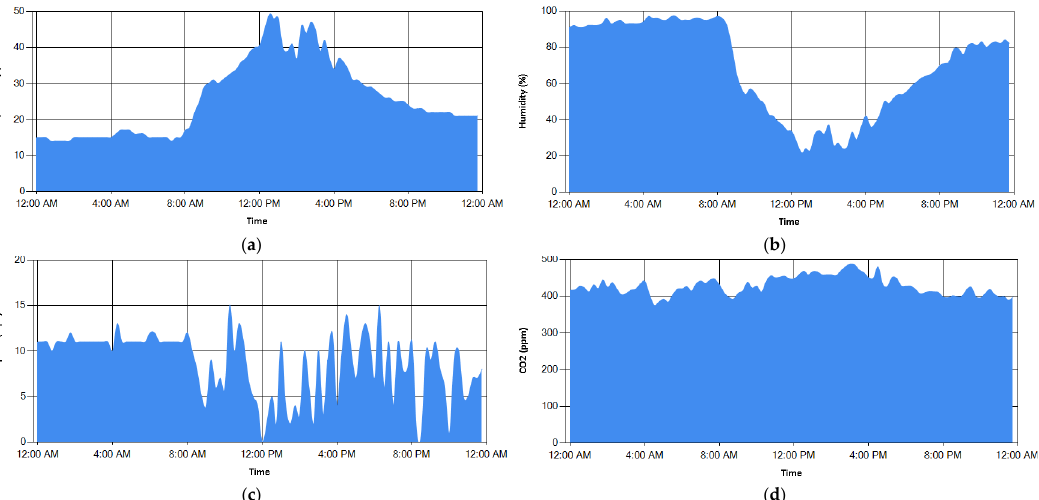
Figure 13. Screenshots of central server software and smartphone apps: ( a ) central server-marked fire event on map; ( b ) smartphone notification when smoke detected in sensor node 0; ( c ) smartphone app’s list view showing a list of fire events with location, date, and time; ( d ) smartphone notification confirming the reception of daily data at midnight.